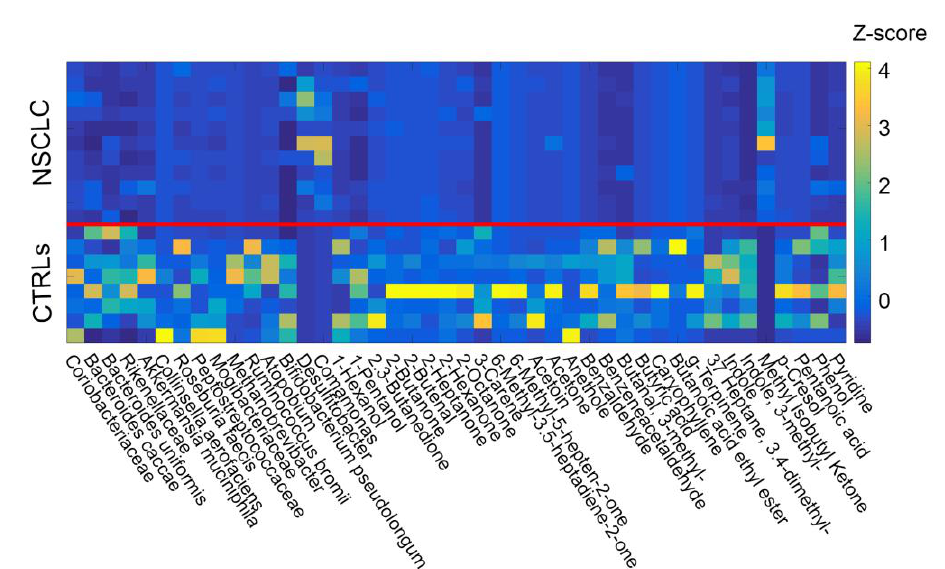
Figure 2. Z scores across subjects (NSCLC = 1–11, CTRLs = 12–19) calculated for the selected elements of the two groups (OTUs and metabolites). At the end of the filtration procedure, forty-four compounds were identified and included in the analysis. Data from patients and controls were merged and cross-correlated. The solid red line helps to separate the two groups (NSCLC and CTRLs).